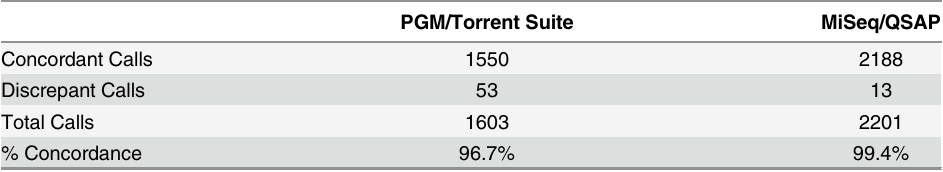
Table 2. Inter-Assay Concordance of Variant Calls vs.